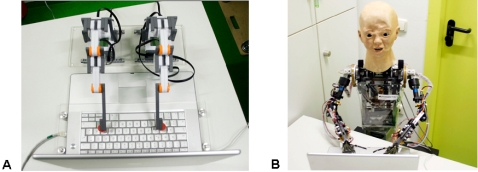
A: Functional Robot, Lego Mindstorms; custom-made keyboard button system; B: Anthropomorphic Robot, BARTHOC Jr. (Bielefeld Anthropomorphic RoboT for Human-Oriented Communication).